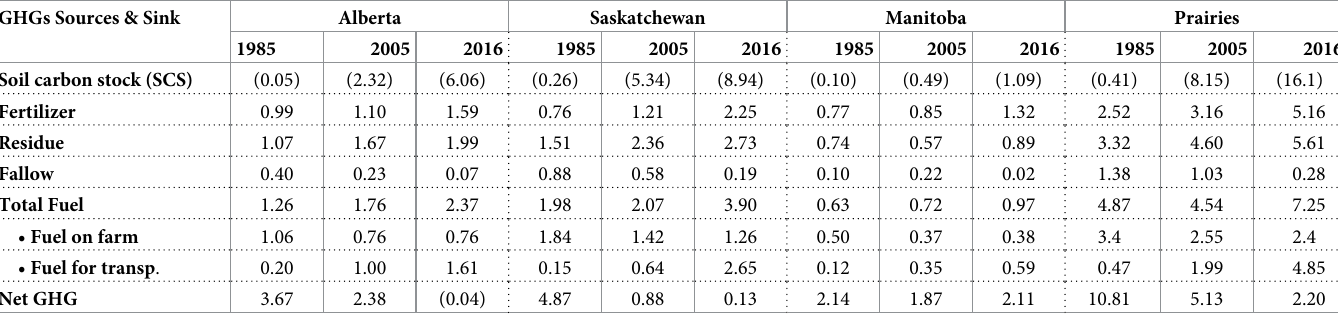
Table 1. GHGs estimates in the Canadian Prairies provinces in the crop sector (Mt CO2-eq). GHGs Sources & Sink Alberta